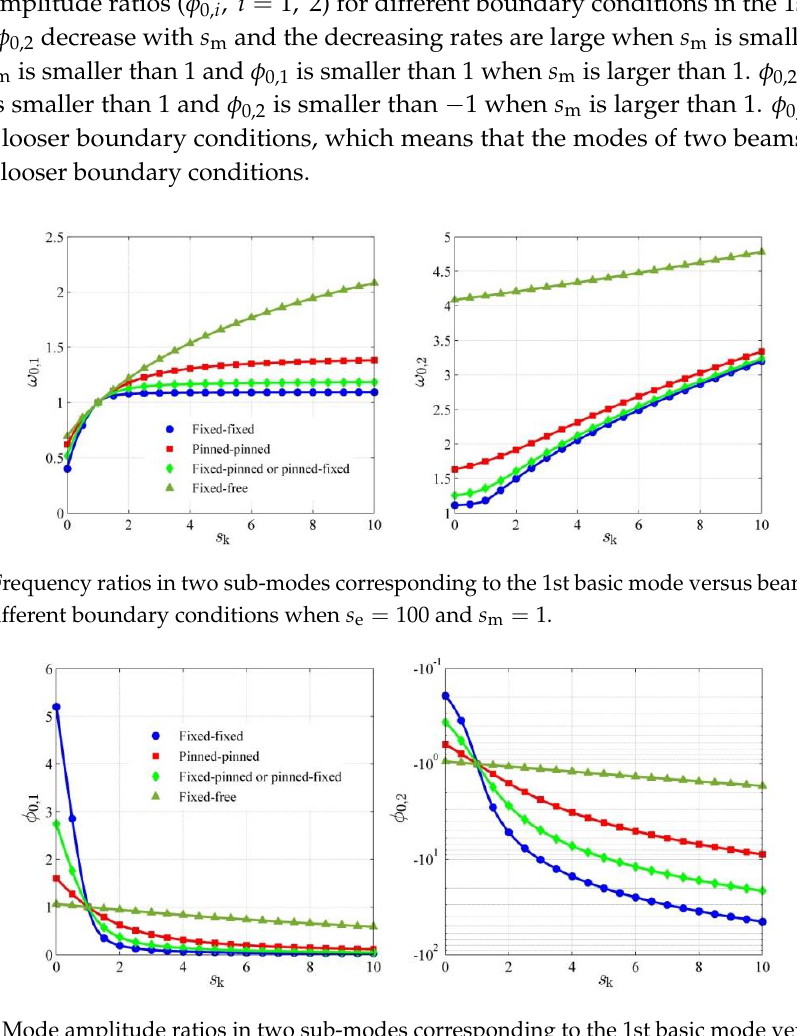
Figure 8. Mode amplitude ratios in two sub-modes corresponding to the 1st basic mode versus contact stiffness ratio for different boundary conditions when 𝑠 e = 100 and 𝑠 k = 1 .